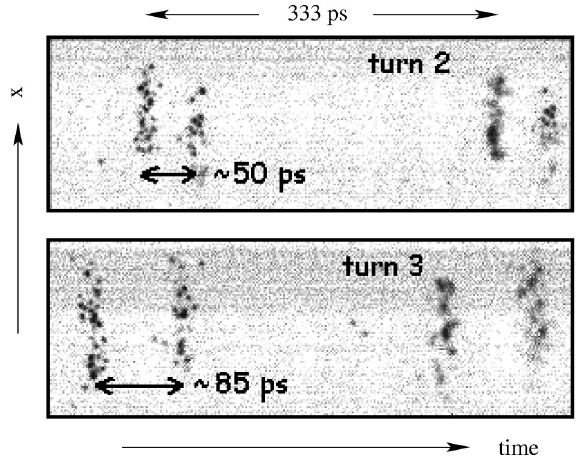
FIG. 25. Turn-to-turn bunch spacing variations during the combination of two pulses with injection errors. The bunch spacing changes from 50 ps at the second turn (top panel) to 85 ps at the third turn (bottom panel).